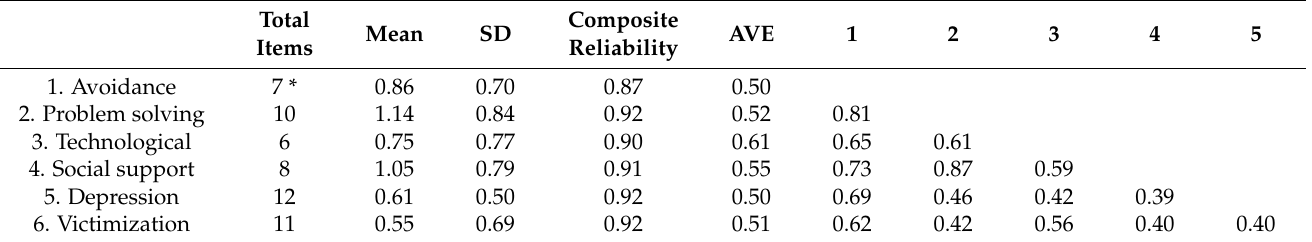
Table 1. Composite reliability, average variance extracted (AVE), and discriminant validity of